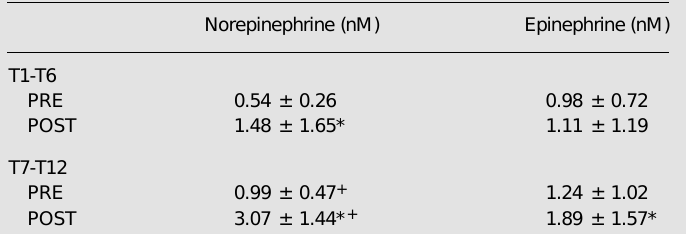
Table 3 - Serum norepinephrine and epinephrine levels at rest (PRE) and immediately after maximal arm crank exercise (POST) in subjects with different levels of